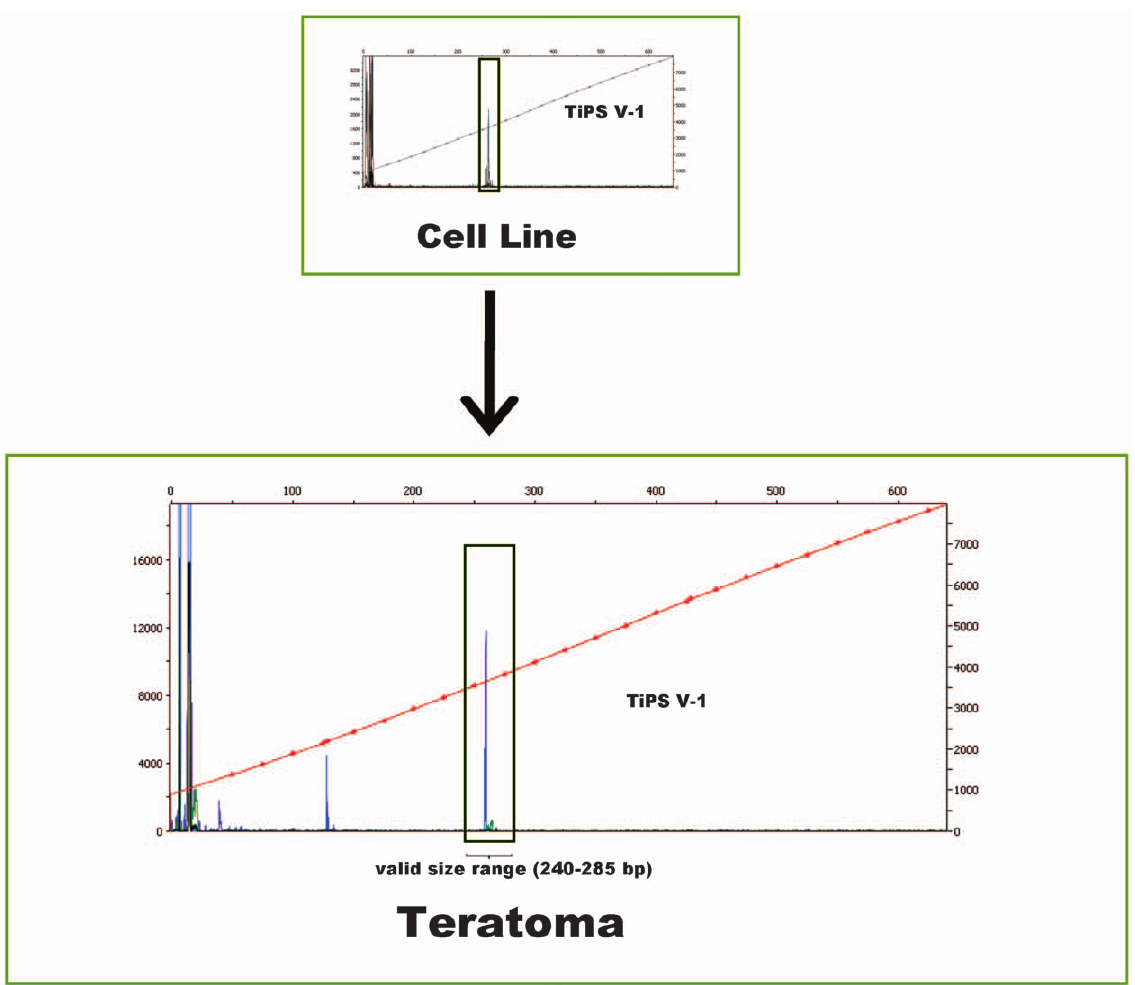
Figure 5. iPSC Clone Tracking. Genomic DNA was isolated from teratoma samples and compared with their parent cell lines for TCR b chain rearrangements. Representative data is shown from cell line TiPS V-1. The derivative teratoma harbors the clonal rearrangement of the parent cell line. PCR analysis was conducted using multiplexed primers targeted to conserved regions within the V-J region of the TCR b locus. DNA fragment analysis was performed on an ABI 3730 DNA analyzer. Background # 1000 RFU.